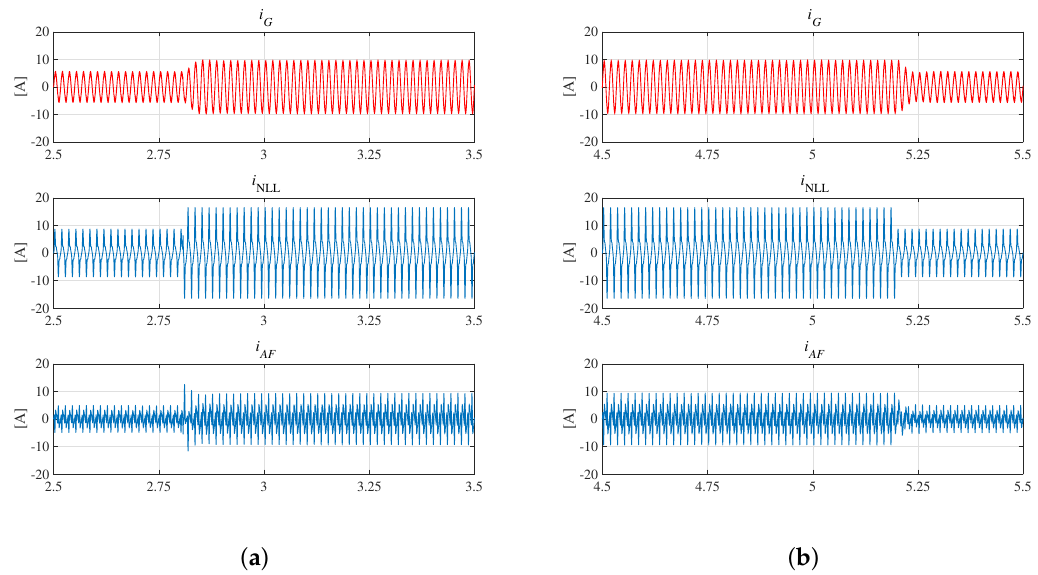
Figure 9. Transient responses of the line current i G , the current consumed by the NLL i NLL , and the current injected by the SAPF i APF , during a change of the power demanded by the NLL: ( a ) from low to high load and ( b ) from high to low